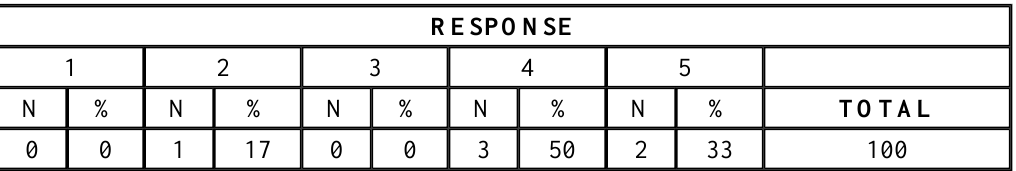
Table 5 Organizations currently implementing BI technologies